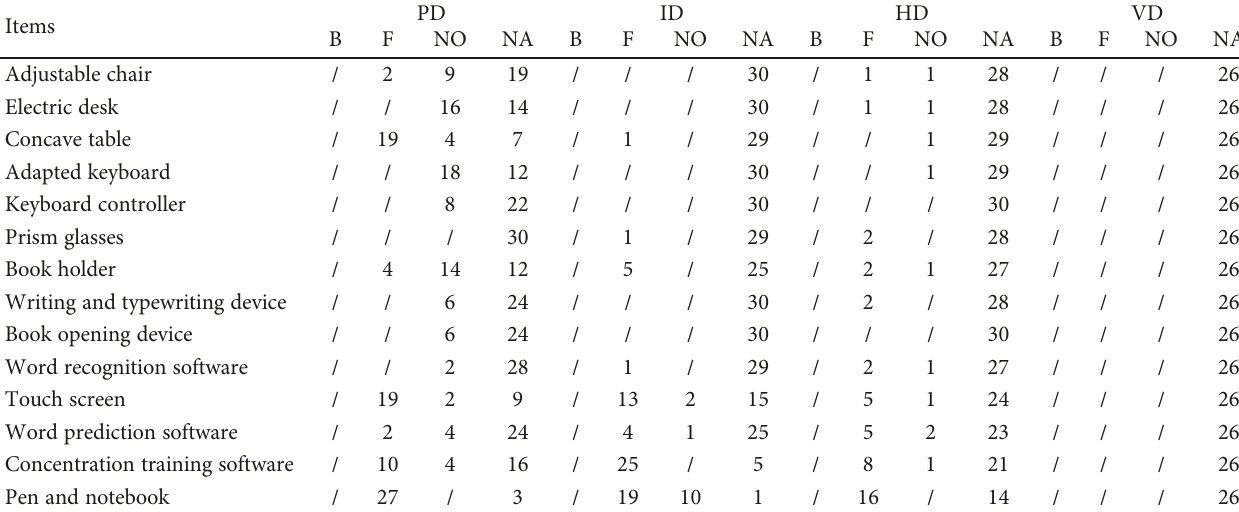
Table 5: Facilitators and barriers of AT for education.